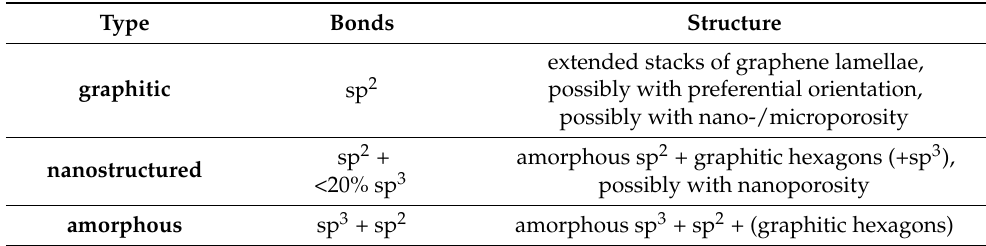
Table 1. Types of carbon films.